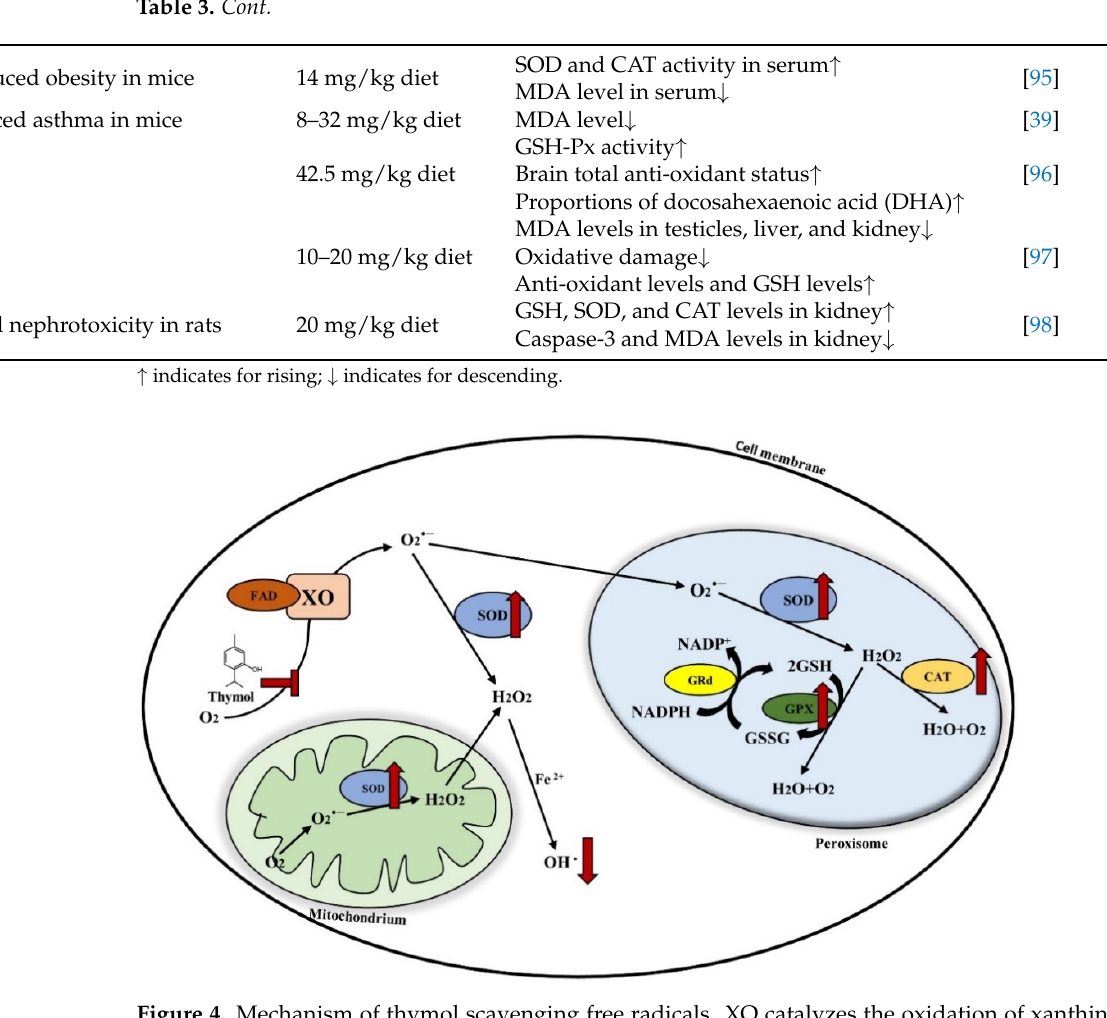
Figure 4. Mechanism of thymol scavenging free radicals. XO catalyzes the oxidation of xanthine and hypoxanthine with increased production of O 2 ·− in purine metabolism or O 2 ·− is generated in the mitochondrial inner membrane through the respiratory electron transport chain. The former enters the peroxisome and the latter is catalyzed by SOD in the mitochondria to generate H 2 O 2 . CAT and GPX in the peroxisome catalyze H 2 O 2 to generate H 2 O and O 2 , and H 2 O 2 in the cytoplasm is affected by Fe 2+ to generate OH · . Elevated levels of free radicals can lead to oxidative stress. Thymol reduces ROS by directly scavenging free radicals, combining with XO, or increasing anti-oxidant enzyme